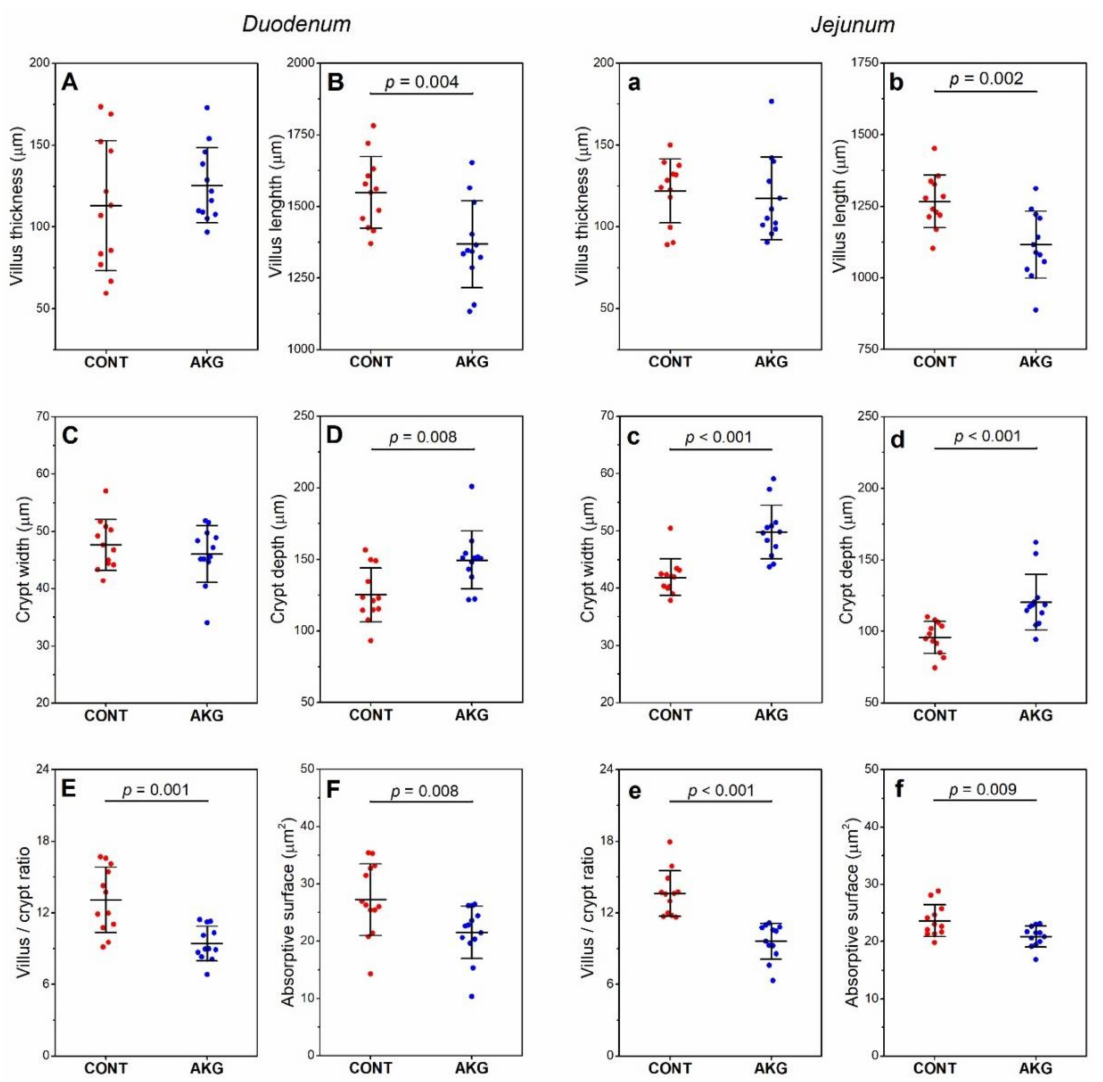
Figure 1. The e ff ect of dietary supplementation with AKG during the experimental period (31–60 weeks of age) on the intestinal histomorphometry of laying hens at the age of 60 weeks in the duodenum ( A – F ) and jejunum ( a – f ). The control (CONT) group included laying hens not supplemented with AKG; the AKG group included laying hens supplemented with AKG at a dose of 1.0% (10 g / kg feed). Data are mean values ± standard deviation (whiskers) from n = 12 laying